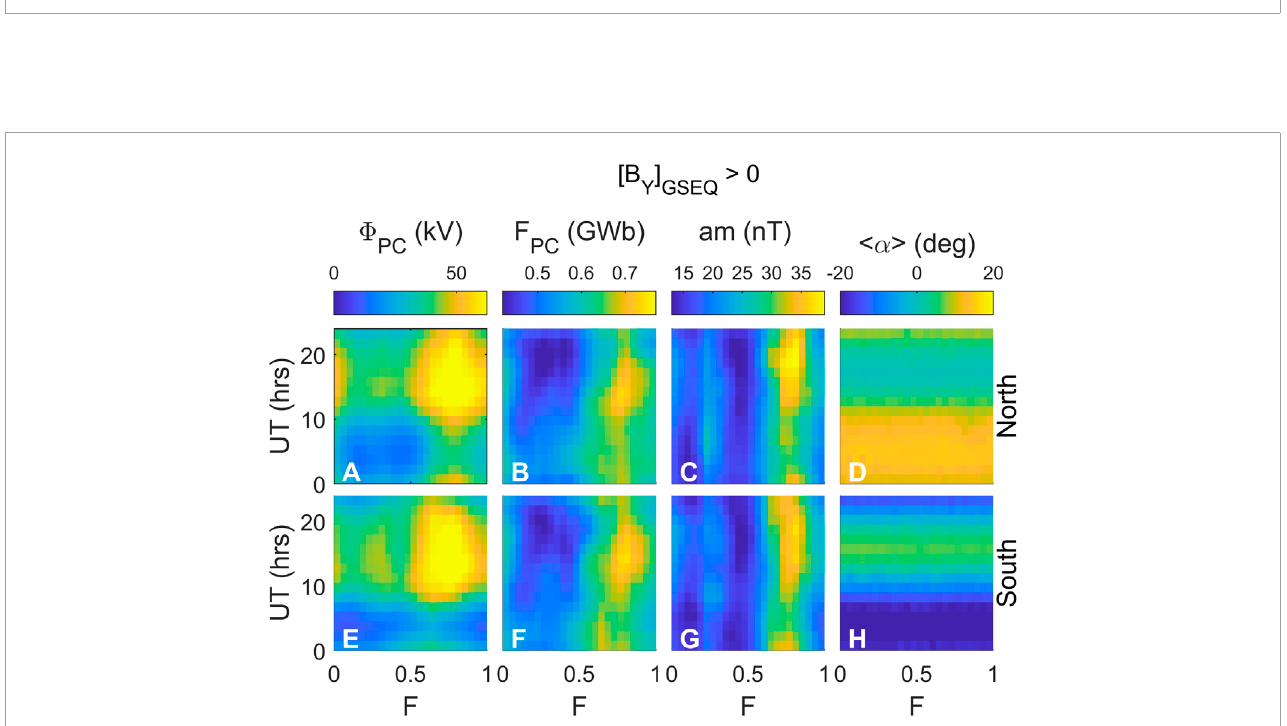
FIGURE 12 F-UT plots of the DMSP F-13 and F-16 satellite data for 2001 and 2002, as processed by Lockwood et al. (2009). The top row is for northern polar cap passes, the bottom for southern polar cap passes. These data are for intervals when the mean IMF [ B Y ] GSEQ component, averaged over the hour prior to the pass, was positive. Mean values are shown in bins that are 1 h wide in UT and (1/16) yr wide in F . Parts (A) and (E) are for the transpolar voltage, Φ PC ; parts (B) and (F) are for the estimate polar cap magnetic flux, F PC ; (C) and (G) are for the am index, linearly interpolated from the three-hourly data to the time of the mid-point of the polar cap traversal. (D) and (H) are for the mean separation of the pass from the ideal 06–18 MLT meridian ⟨ α ⟩ , where α is the mean of the latitudinal deviations from the dawn-dusk meridian of the points of maximum and minimum potential along the orbit track. Because of the relatively short data series, 3-point running-mean smooths have been applied in both the F and UT